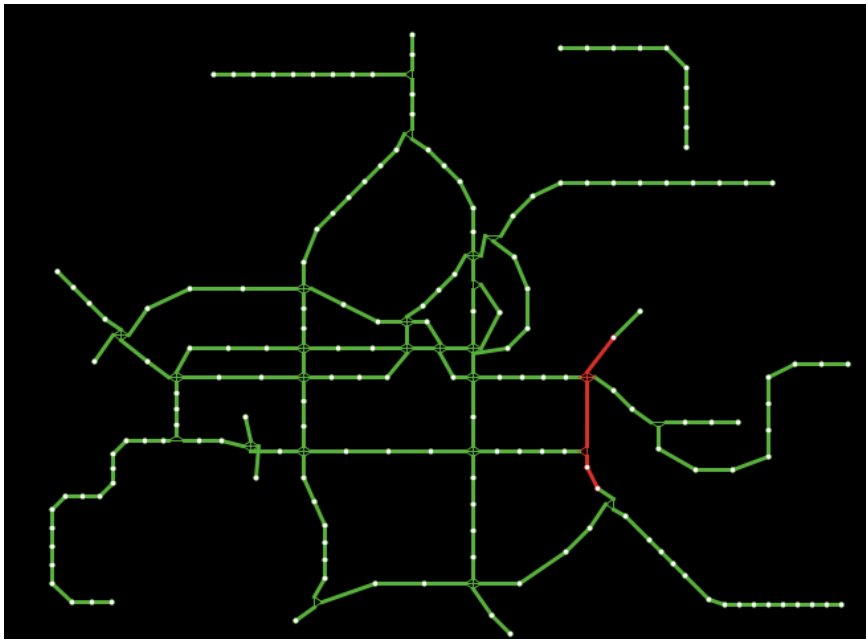
Figure 7. Congestion in GZM network.